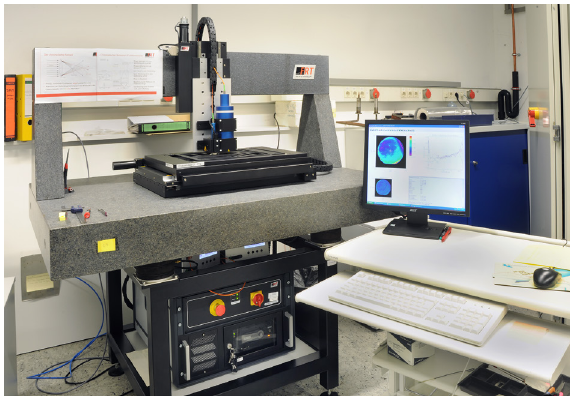
Fig. 1. MicroProf ® -system.